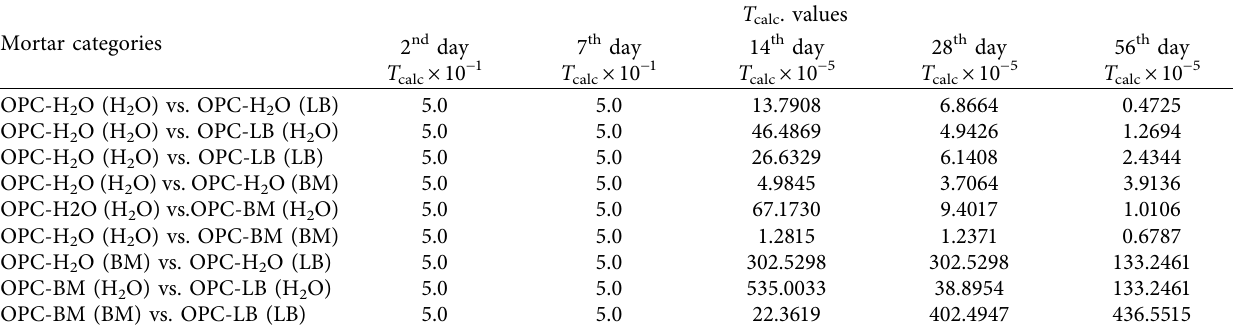
Table 3: T calc. values summary for microbial mortars against control mortar and among varied microbial mortar categories flexural strength across 2 nd , 7 th , 14 th , 28 th , and 56 th day of curing ( T crit . � 0.5, p � 0 . 05). Mortar